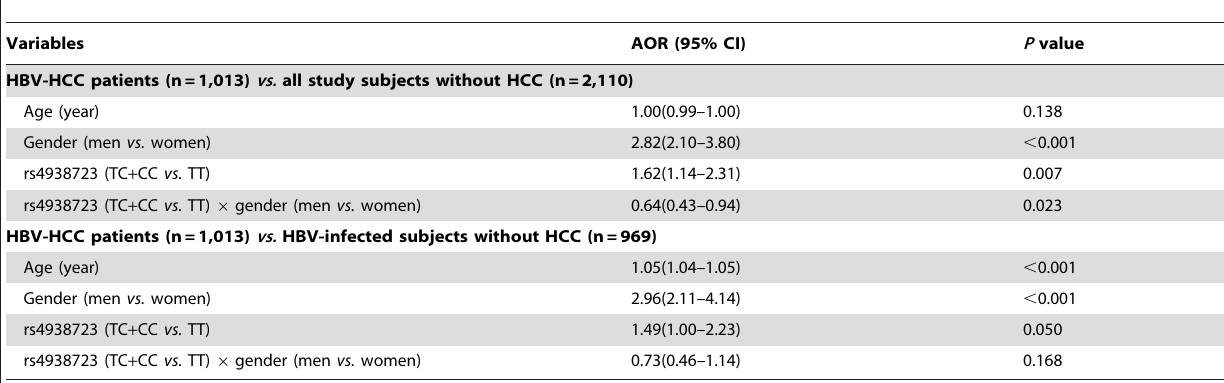
Table 2. Contribution of multiplicative interactions pri-miR-34b/c (rs4938723, T . C) with gender to HCC risk in multivariate regression analyses.